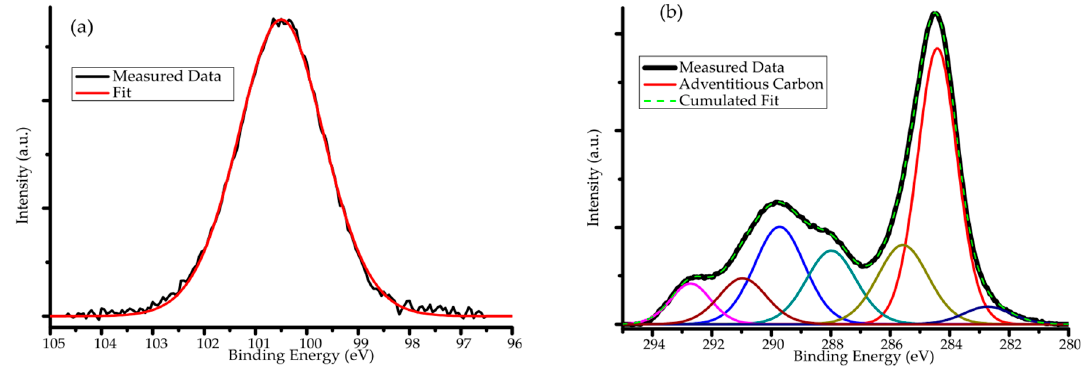
Figure 4. XPS spectrum and peakfit of ( a ) the Si 2p peak and ( b ) the C 1s peak in the sample.